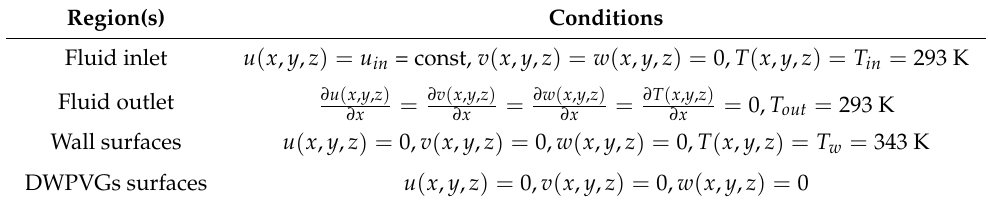
Table 1. Boundary conditions of the simulation.